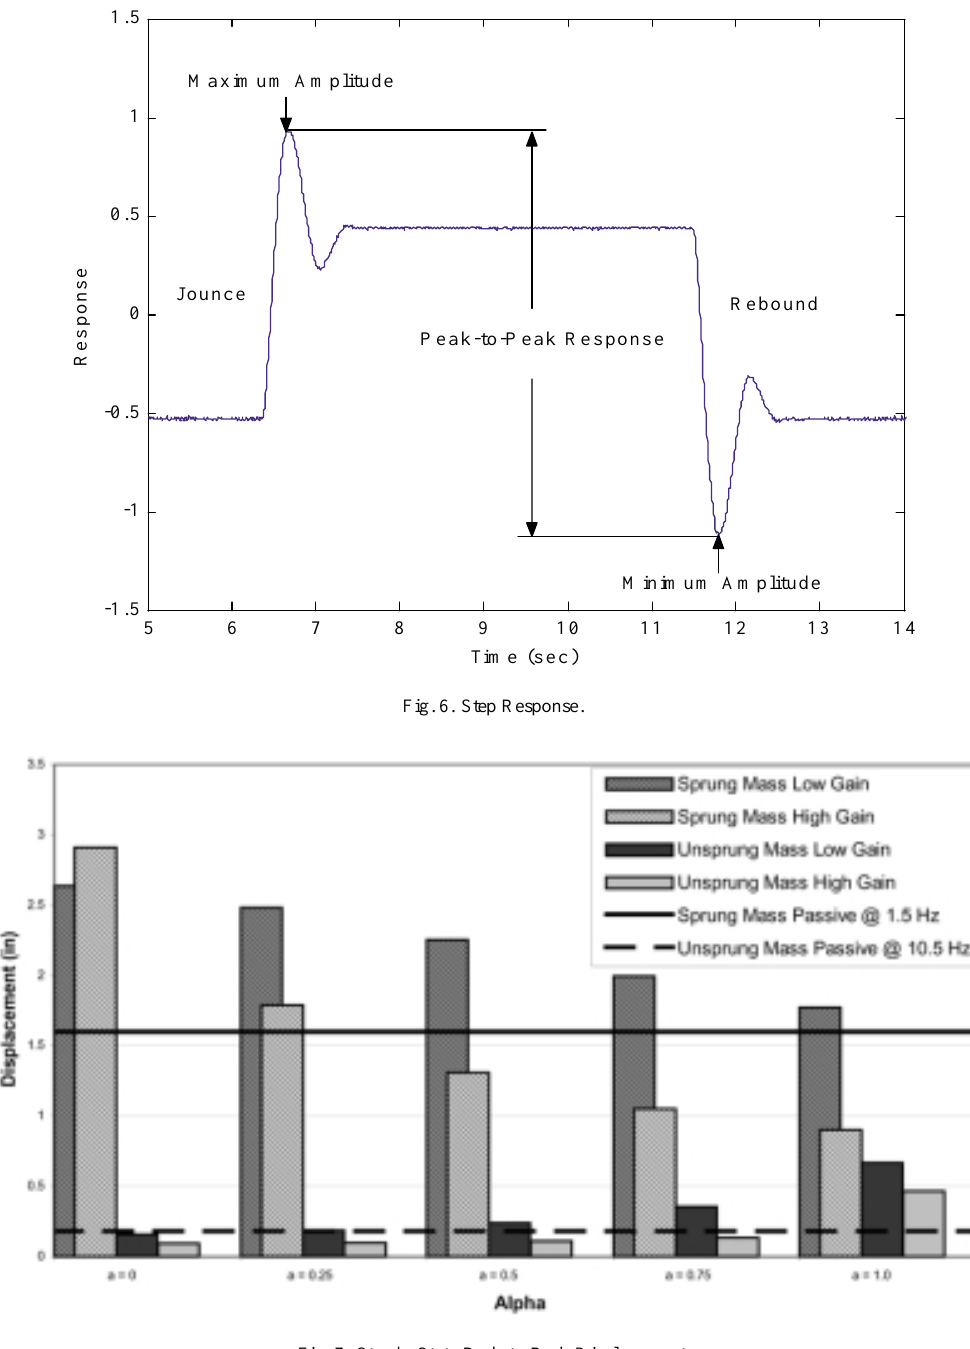
Fig. 7. Steady-State Peak-to-Peak